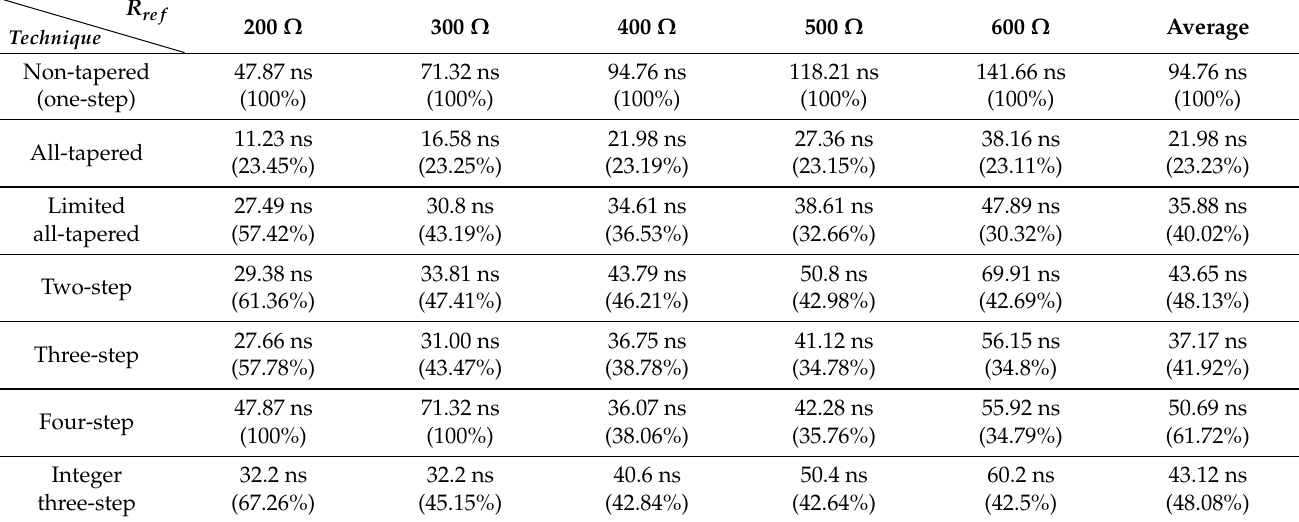
Table 1. Minimum required total conversion time according to different tapering